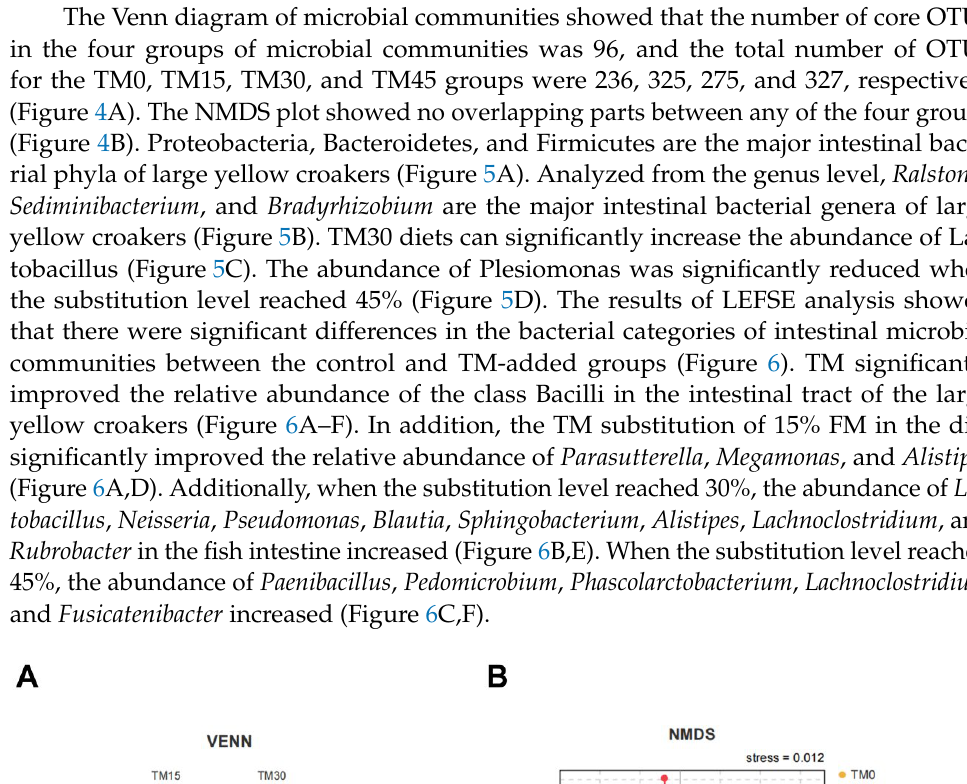
b, c, d) indicate a significant difference between experimental diets, by Tukey’s test ( p < 0.05).